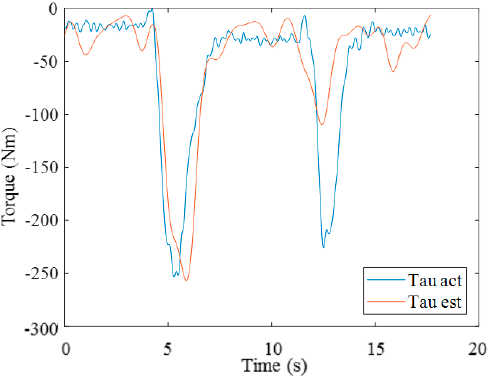
Figure 11. Results from estimating muscle torque using the GA in Trial